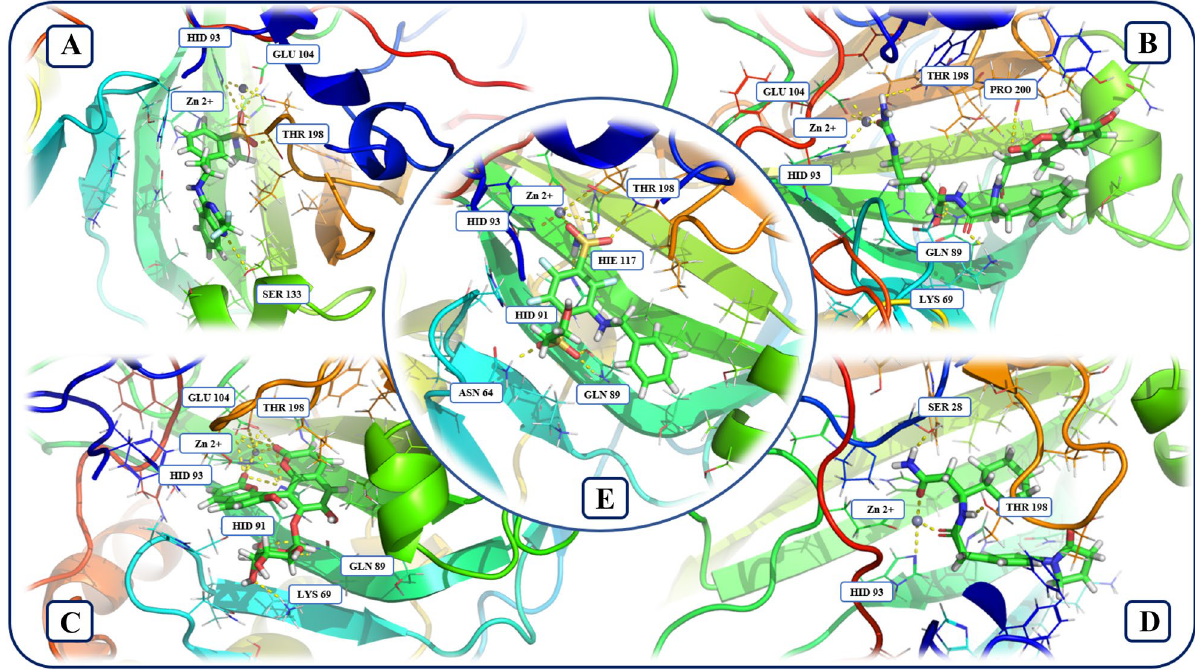
Figure 7. Interaction of the selected compounds with amino acid residues and Zn 2+ ion in the binding site of the hCA XII isozyme. ( A ) ZINC66466630, ( B ) ZINC70704873, ( C ) ZINC49181869, ( D ) ZINC82980951, ( E ) Reference. Figures of complexes were obtained using PyMOL v. 2.3.2 (https:// pymol. org). Schematic illustration was drawn using Adobe Illustrator 2018 (www. adobe. com/ produ cts/ illus